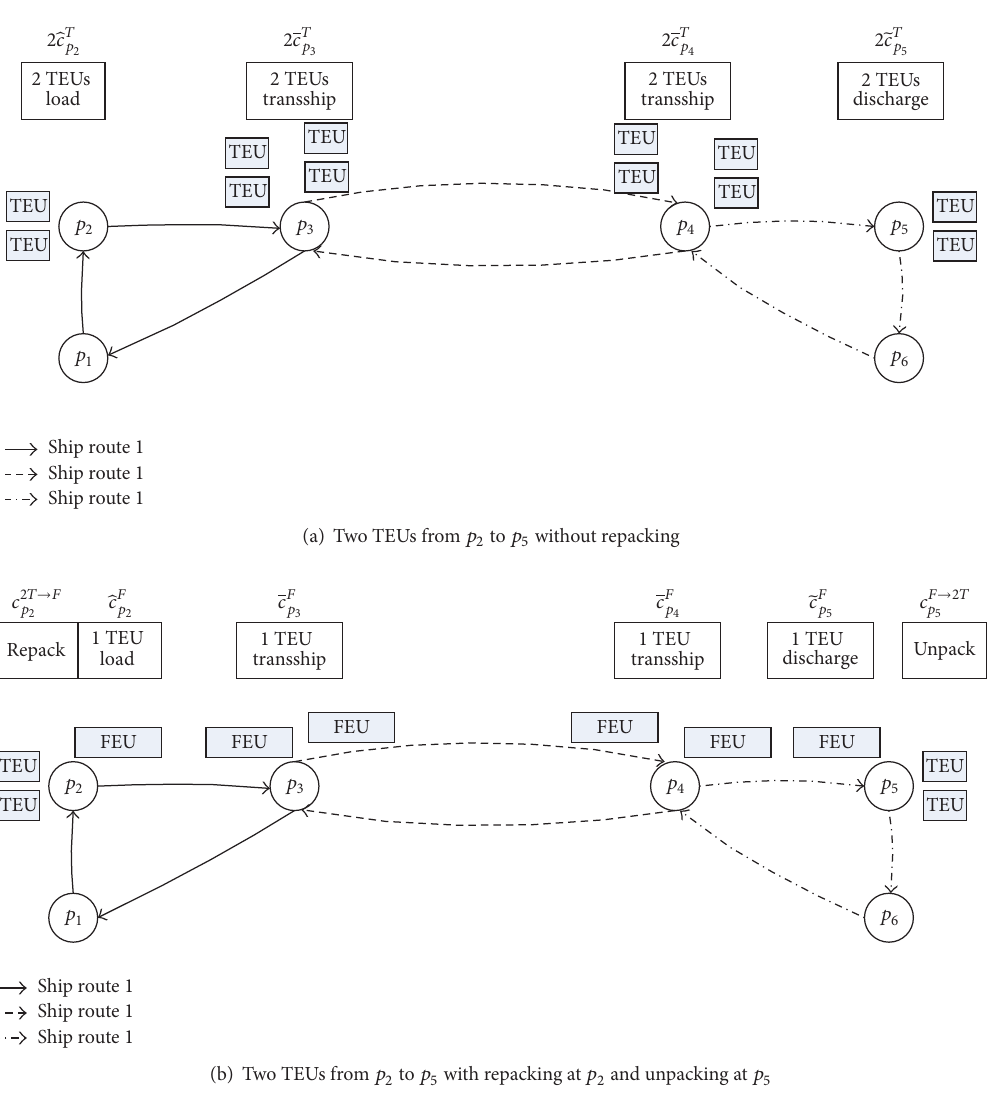
Figure 2: Container packing with the same origin and